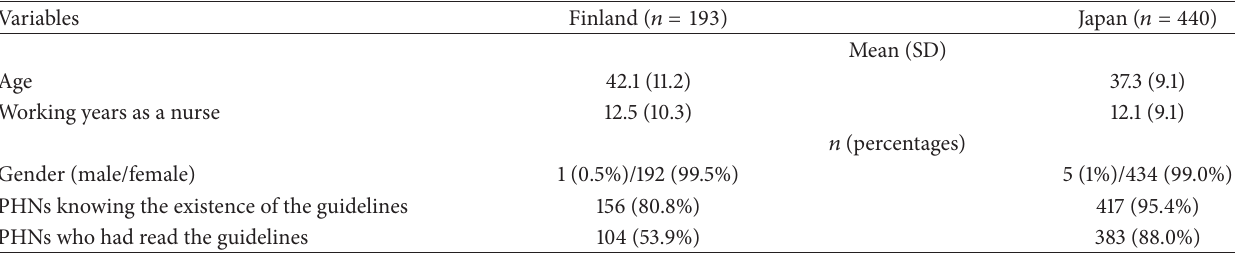
Table 1: Background of the participants.